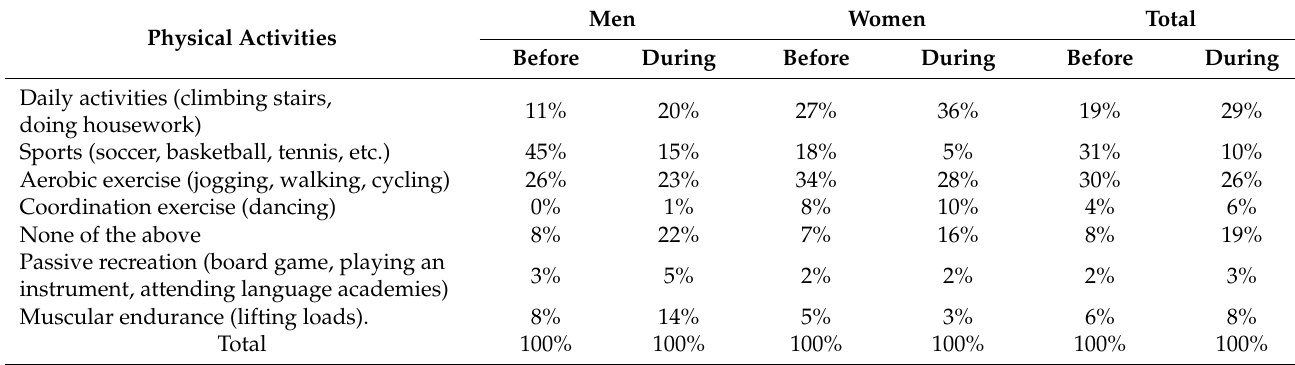
Table 5. Physical activity before and during the pandemic.